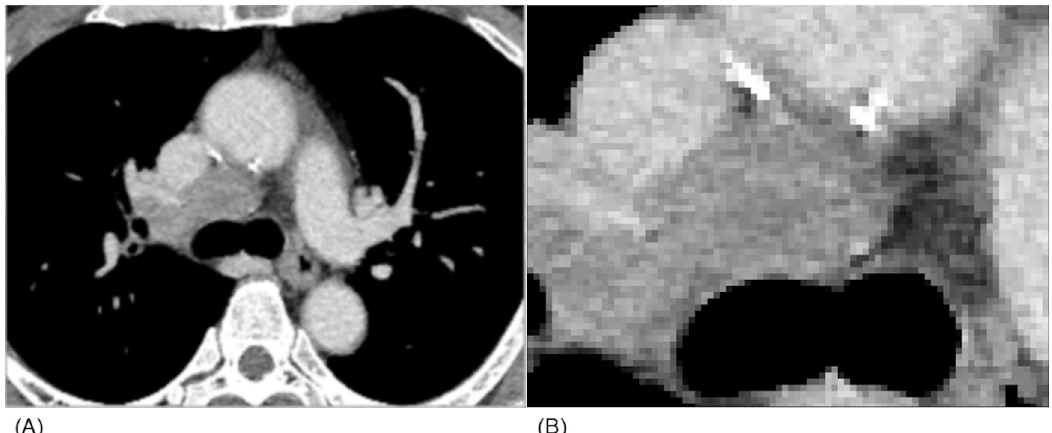
Fig 1. CT image of lymph node metastasis from small cell lung cancer. A large lymph node, which was proven by a transbronchial needle aspirate to be a lymph node metastasis of small cell lung cancer, is depicted on an enhanced CT image (A). Density and contrast enhancement of the node appears slightly heterogeneous; however, massive necrosis is not observed (B). https://doi.org/10.1371/journal.pone.0243181.g001 For the 24 patients who underwent diagnostic EBUS-TBNA of their mediastinal lymph nodes, the biopsied lymph nodes were identified on CT scans and analyzed. For the remaining 6 SCLC patients who did not undergo EBUS-TBNA, texture analysis was performed on the larg- est of the enlarged mediastinal lymph nodes. A 10-mm-diameter region of interest (ROI) was placed on the center of the lymph node to be analyzed, by a single-blind observer who did not know the ultimate diagnosis of each patient. We assessed several texture features, using an open-source software module (LIFEx: http://www.lifexsoft.org) (Fig 3). Texture features were classified as follows: 5 histogram features, 7 gray level co-occurrence matrix (GLCM) features, 8 gray level run length matrix (GLRLM) features, 3 neighborhood gray level different matrix (NGLDM) features, and 8 gray level zone length matrix (GRZLM) features [20–22]. CT images were displayed on a LIFEx monitor with a window level of 40 Hounsfield Units (HU) and a window width of 350 HU.